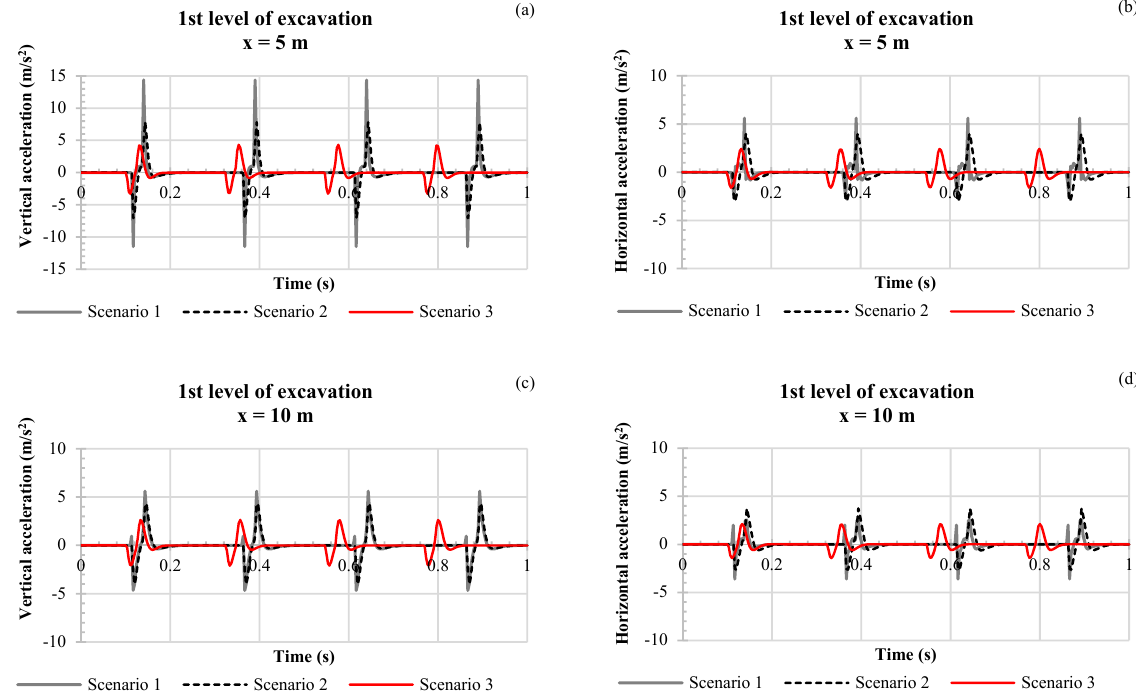
Figure 6. Comparison between different excavation scenarios: vertical and horizontal acceleration time histories obtained at a distance of ( a , b ) 5 m and ( c , d ) 10 m from the symmetry axis during the second excavation stage.